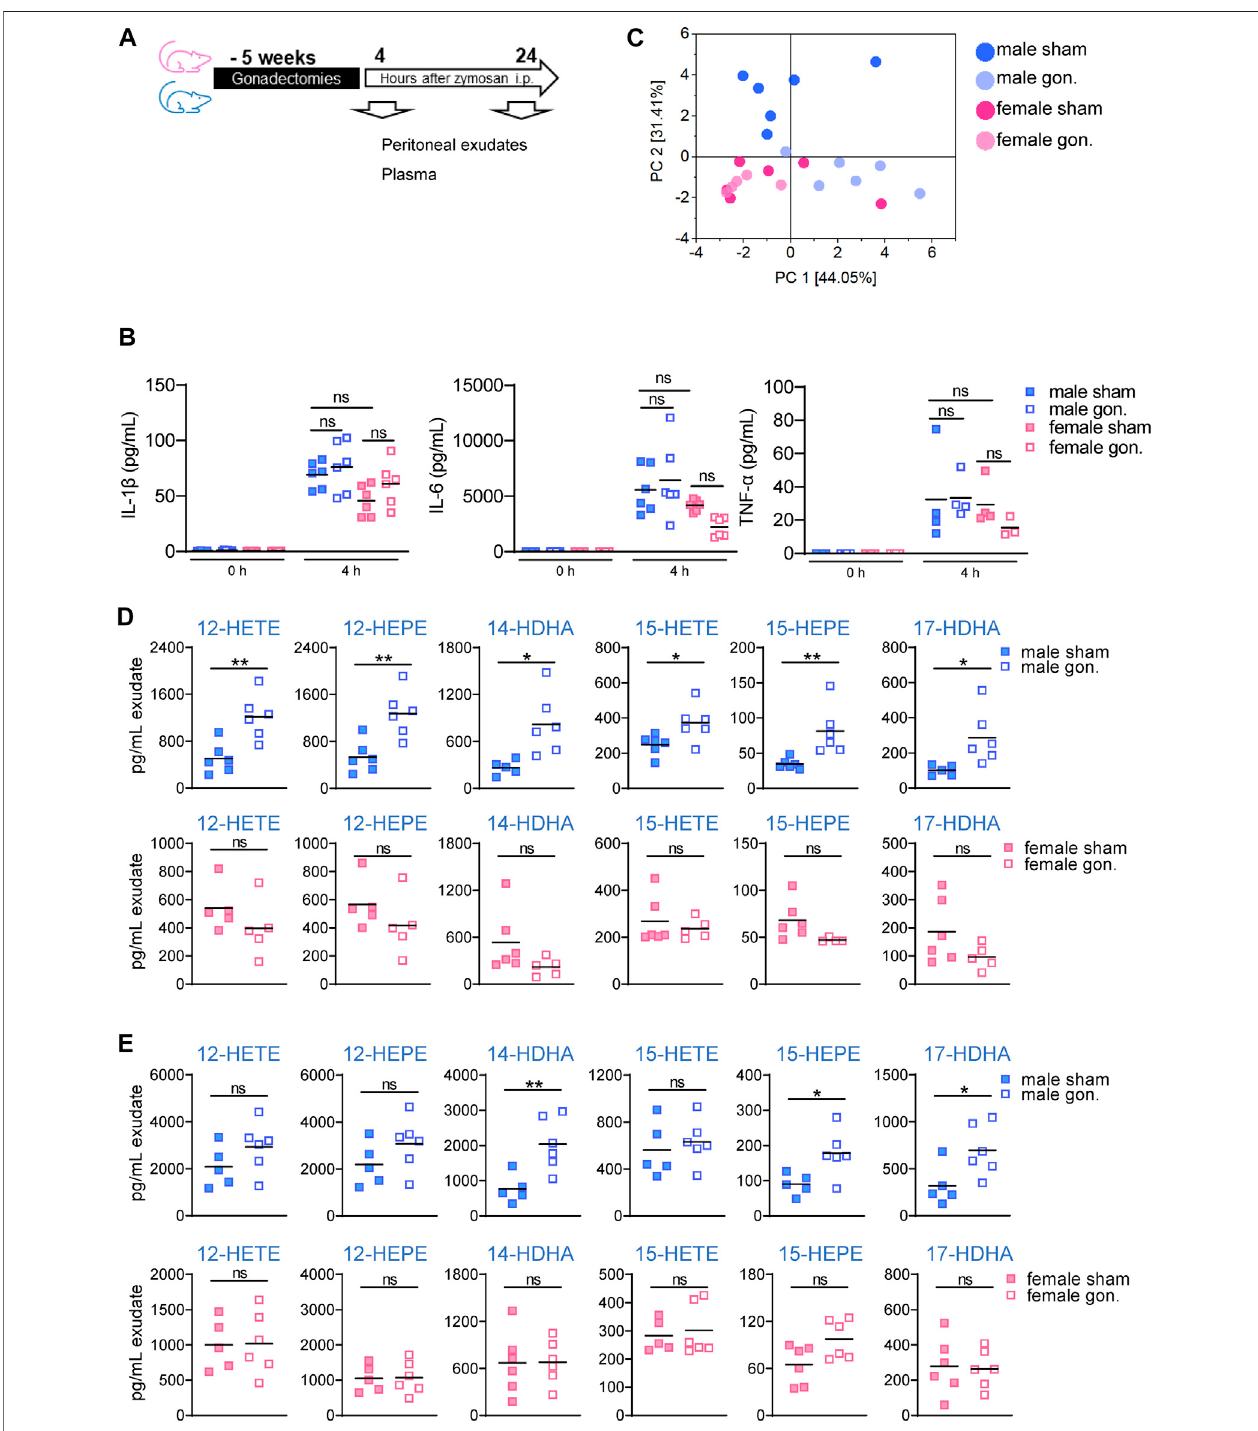
FIGURE2| EffectofhormonedepletionontheLMcontentinperitonealexudatesfrommaleandfemalemiceuponperitonitisinduction. (A) Experimentalsetupand timeline. (B) Amounts ofpro-in fl ammatorycytokinesIL-1 β ,IL-6, andTNF- α inperitonealexudatesofgonadectomized andnon-gonadectomized (sham-operated) male and female mice after treatment with vehicle (no zymosan (cid:1) 0 h) and 4 h after zymosan injection. Results are shown in pg/mL exudate in scatter dot plots as individual data points and means as black line; n (cid:1) 4 – 6; ordinary one-way ANOVA with Tukey ’ s multiple comparison test. (C) Principal component analysis of LM pro fi les in theexudatesfromgonadectomizedandnon-gonadectomized(sham-operated)maleandfemalemice,4 hafterzymosaninjection(correspondingrawdataareshownin Table 2 ). (D,E) Amounts of 12/15-LOX products in peritoneal exudates of gonadectomized and non-gonadectomized (sham-operated) male and female mice 4 h (D) and 24 h (E) after zymosan injection. Results are shown in pg/mL exudate in scatter dot plots as individual data points and the means as black lines; n (cid:1) 5 – 6; * p < 0.05, ** p < 0.01 non-gonadectomized vs. gonadectomized; unpaired Student ’ s t test; ns (cid:1) not signi fi cant.